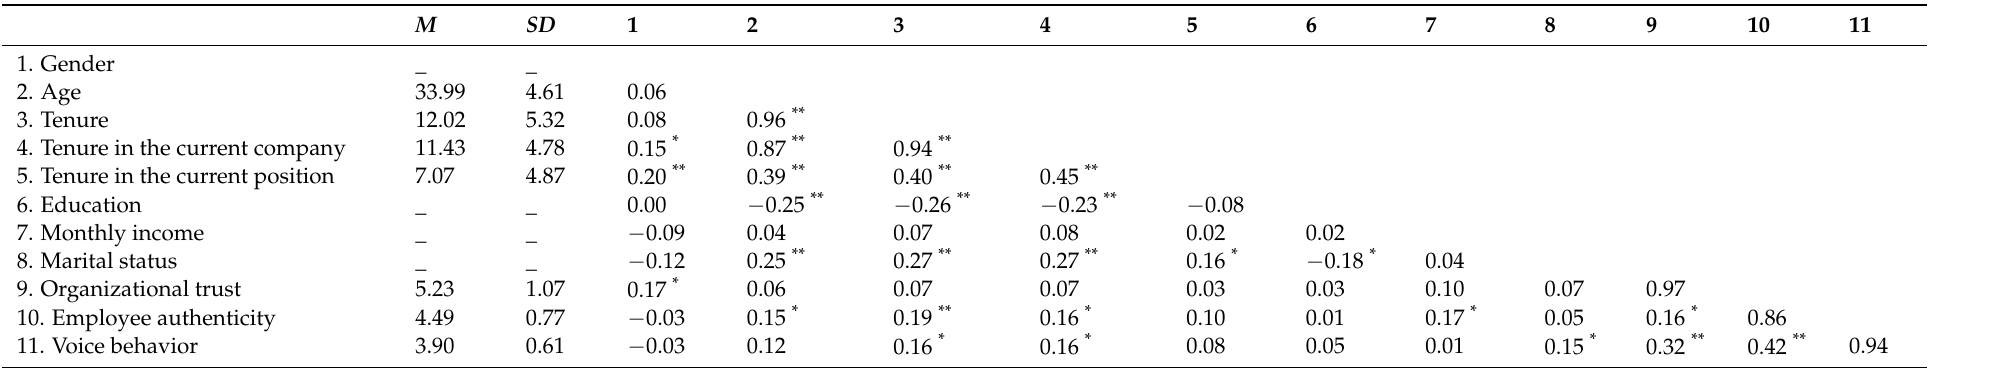
Table 3. Descriptive statistics and correlations among variables ( n =